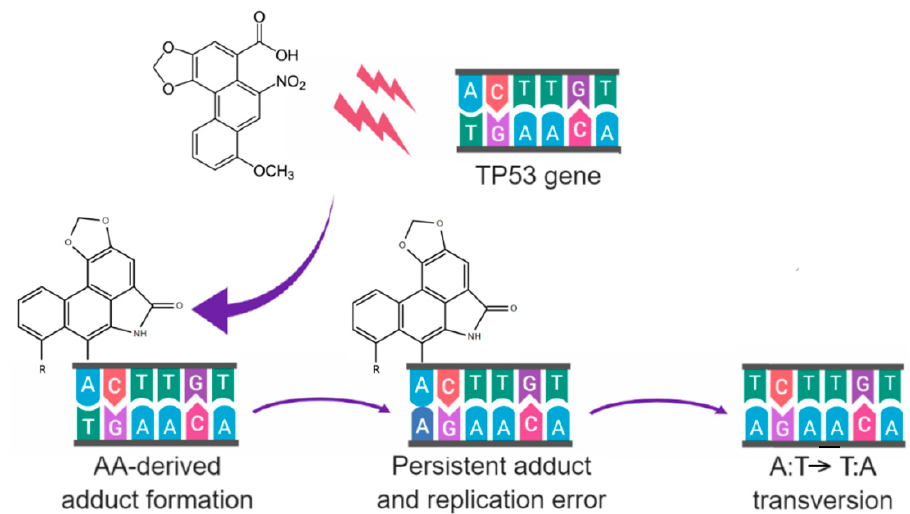
Figure 1. An example of AA-derived DNA adducts leading to gene mutations. After reductive metabolism, AA-derived DNA adducts are bound to the exocyclic amino groups of purine bases through their electrophilic cyclic N -acylnitrenium ion. If the adducts persisted through DNA replications, mutations, such as an A:T → T:A transversion in TP53 gene, may occur.